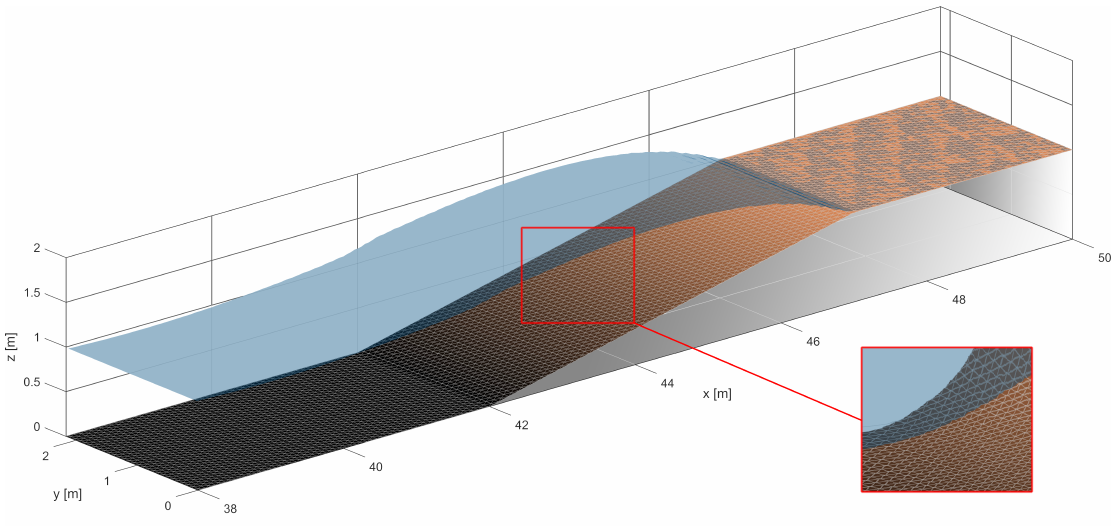
Figure 7. The numerical domain and the triangular equilateral mesh used in the flat reef run-up test. The red box highit a magnified area of the mesh. The surface elevation correspond to t ∗ = 55.1. A solitary wave with a dimensionaless wave height of H / h 0 = 0.5 was generated at the inlet of numerical flume and a Manning coefficient n = 0.012 was adopted to reproduce the roughness of the bottom of the flume. In Figure 8 are shown the model results compared to the measured data [5] at (cid:112) g / h 0 13 dimensionaless time steps t ∗ = t ·